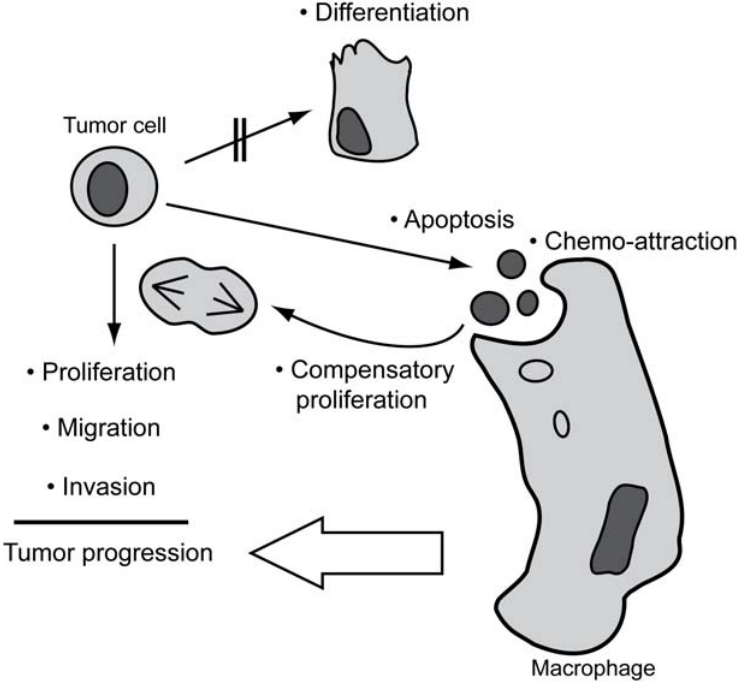
Figure 1. Established functions (•) of caspases and their potential contribution to tumor progression. By triggering apoptosis, caspases will provoke compensatory proliferation and chemo-attraction of macrophages. The latter may indirectly accelerate the progression of tumors. When the differentiation-inducing functions of caspases are blocked, caspases may promote proliferation and stimulate migratory behavior and invasiveness of tumor cells that are not undergoing